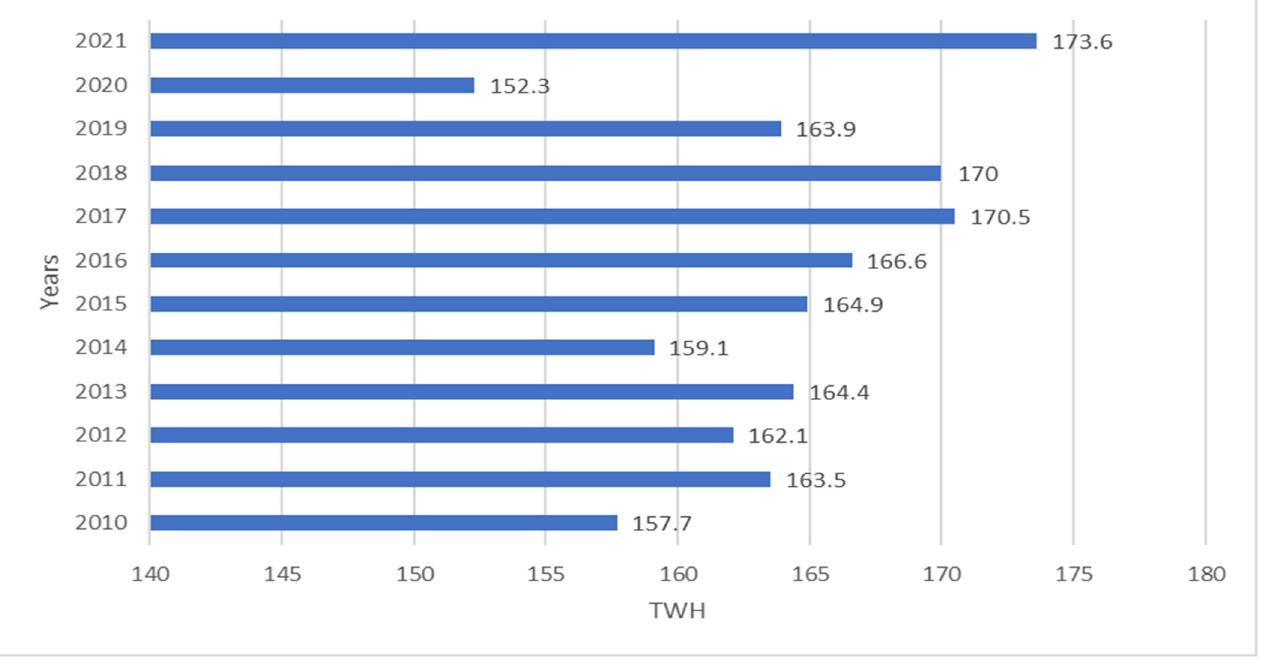
Energies 2022 , 15 , x FOR PEER REVIEW Figure 5. Electricity production in Poland in 2010–2021 (%) . Source: own elaborations based on [44].